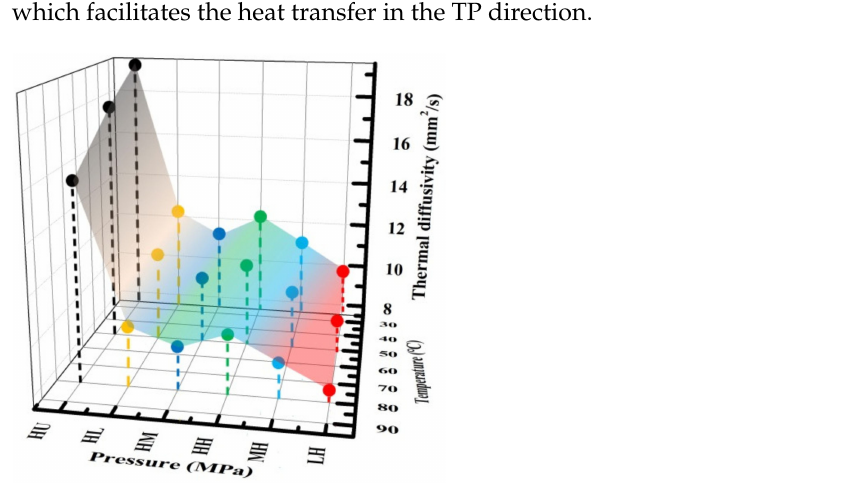
Figure 5. Through-Plane (TP) thermal diffusivity of composite BPs at different temperatures.